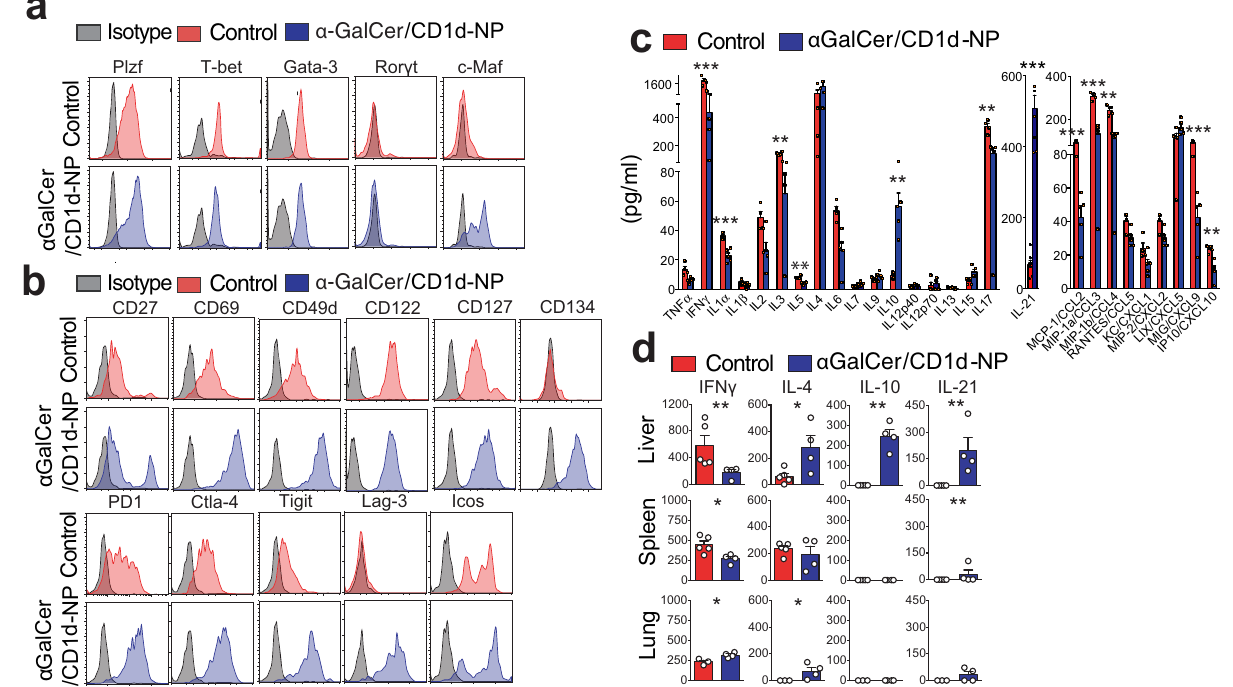
Fig. 3 Phenotypic and cytokine pro fi les for control and α GalCer/CD1d-NP-challenged LiNKT cells. a Representative fl ow cytometric histogram pro fi les for TF staining in LiNKTs of control ( n = 5, untreated) and α GalCer/CD1d-NP-treated NOD. c3c4 mice ( n = 4). b Representative fl ow cytometric histogram pro fi les for iNKT cell surface markers of control ( n = 5, untreated) and α GalCer/CD1d-NP-treated NOD. c3c4 mice ( n = 4). c Cytokine and chemokine pro fi les of anti-CD3/anti-CD28 mAbs-stimulated LiNKT cells of α GalCer/CD1d-NP-treated ( n = 5) vs. control NOD. c3c4 mice ( n = 4, Cys-NP-treated). d Secretion of IFN γ , IL-4, IL-10, and IL-21 by anti-CD3/anti-CD28 mAb-stimulated, α GalCer/CD1d tetramer + cells isolated from the liver, spleen, or lungs of control ( n = 5, untrated) and α GalCer/CD1d-NP-treated NOD. c3c4 mice ( n = 4). Data in a – d were generated using cells isolated 2 – 3 days after the last α GalCer/CD1d-NP dose. Data are represented as means ± SEM and were compared using one tail Mann – Whitney U test ( d ) or multiple t -test